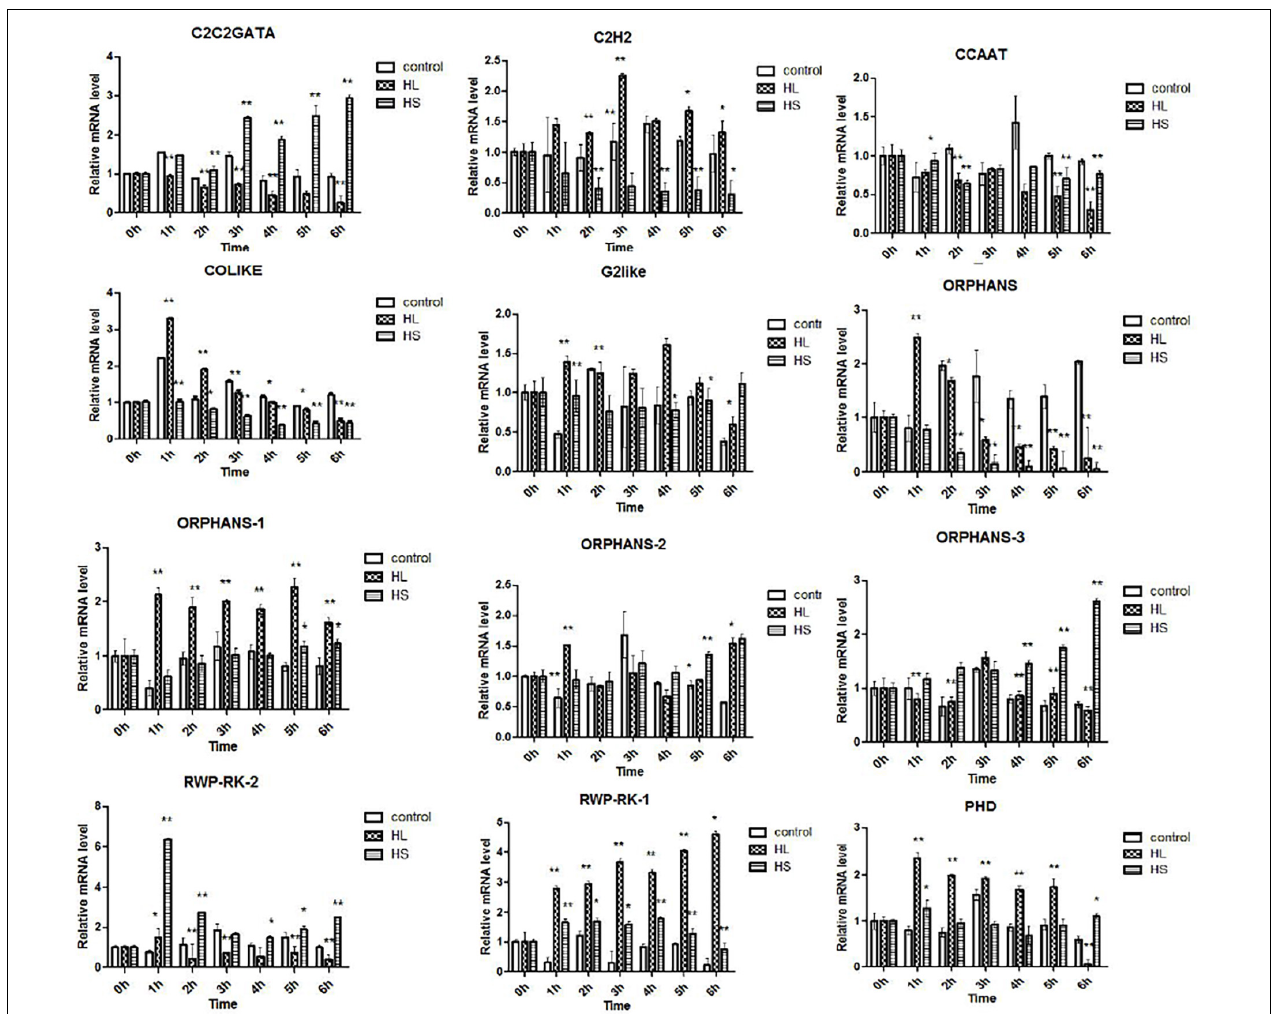
FIGURE 7 | Transcription profiles of transcription factors (TFs) under high light and sodium acetate stress. Control represents control group, HL represents high light stress, and HS represents sodium acetate stress. *Indicates significant difference at level of 0.05, and **indicates significant difference at level of